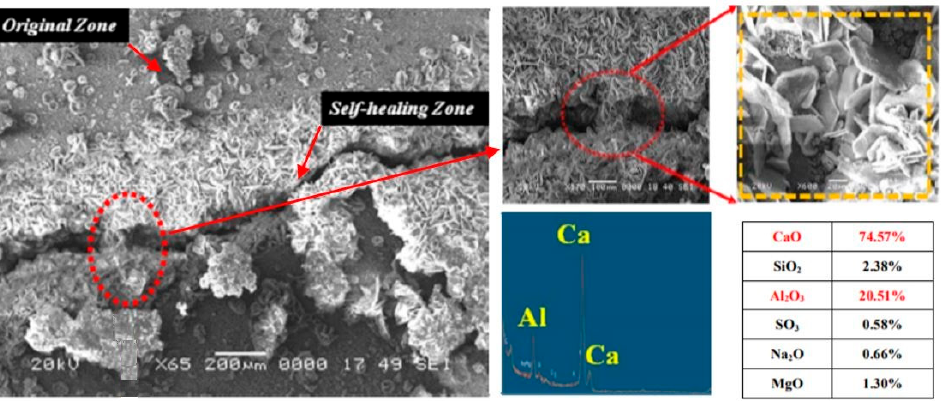
Figure 5. Microstructure of results between self-healing area and original area [45] .